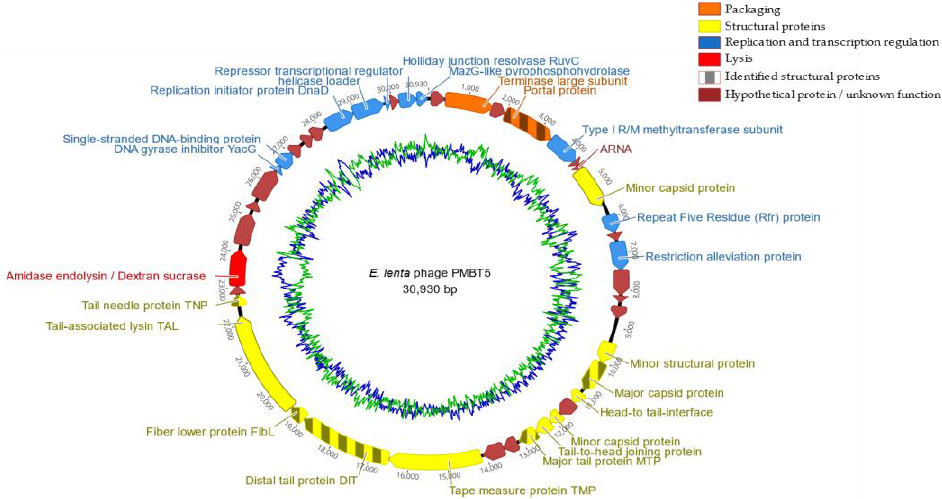
Figure 3. Genome map of E. lenta infecting phage PMBT5 with mol% GC content shown as an inner circle. ORFs are color-coded according to their predicted function. The genome was subdivided into functional modules as demonstrated by colors (for details see legend). The genome starts with the ORF upstream of the putative terminase large subunit (ORF2) shown at the top of the map. The map was generated using Geneious version 11.0. The genome is displayed here as circular molecule for a better overview, although the molecule is actually linear. The green line represents the mol% AT content while the blue line represents the mol% GC content. Striped ORFs indicate that the corre- sponding deduced proteins were confirmed by mass spectrometry.